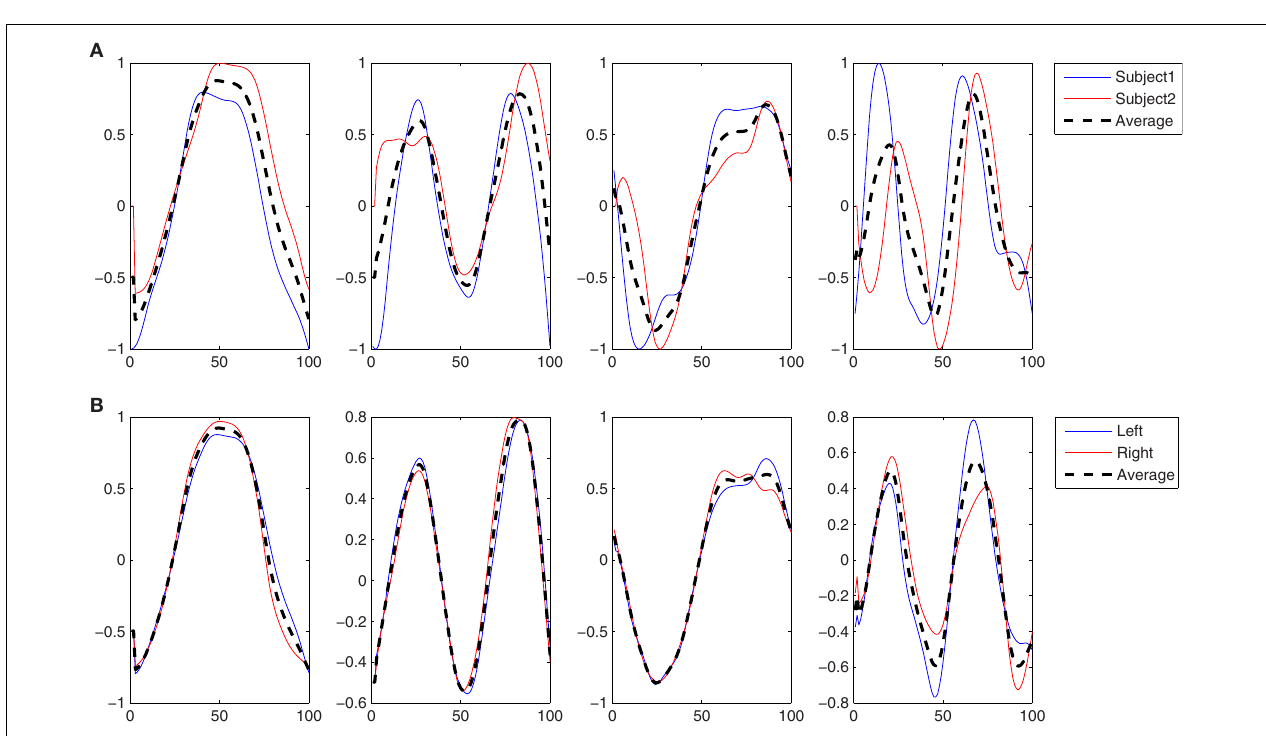
FIGURE 5 | (A) The four kMPs extracted from the two subjects reaching a target with the left hand while walking. (B) Comparison between the average kMPs of reaching a target with the left and the right hand.